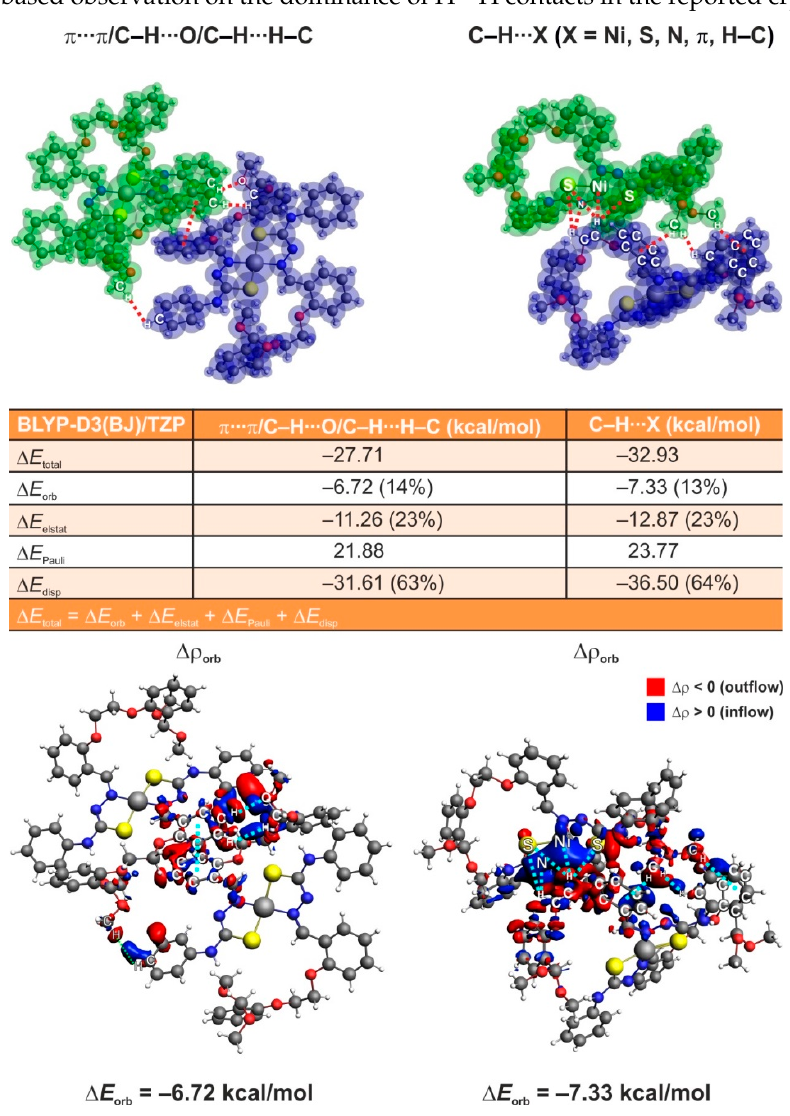
Figure 9. The results of ETS-NOCV energy decomposition describing the cooperativity of π ∙∙∙ π , C–H ∙∙∙ O and C–H ∙∙∙ H–C (left), and C–H ∙∙∙ X (X = Ni, S, N, π , H–C) (right) interactions in 2 . Additionally, the involvement of the nickel(II) d-orbitals is depicted.